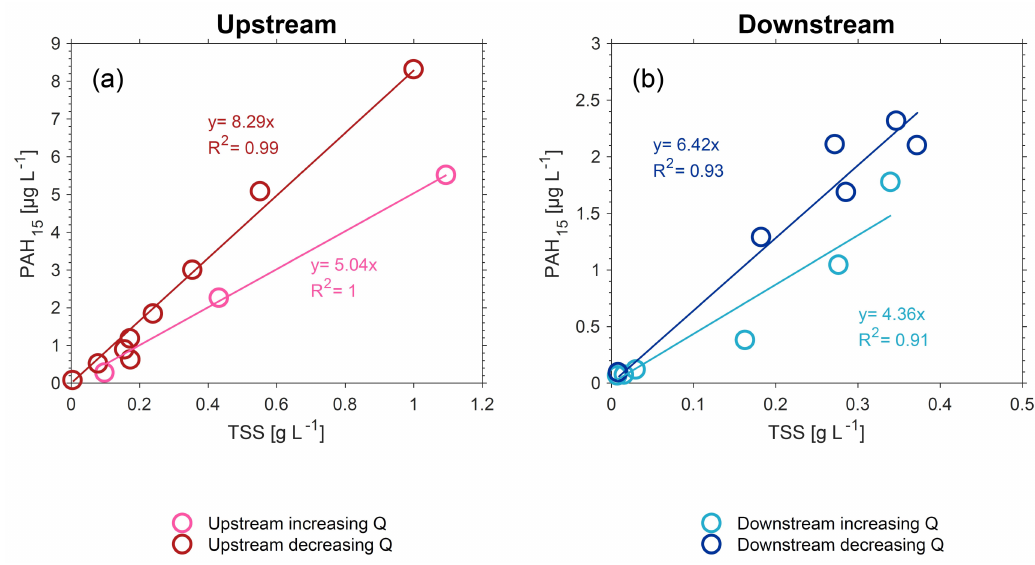
Figure 3. PAH 15 –TSS relations for the upstream ( a ) and downstream ( b ) location split up into samples under increasing and decreasing discharge conditions.